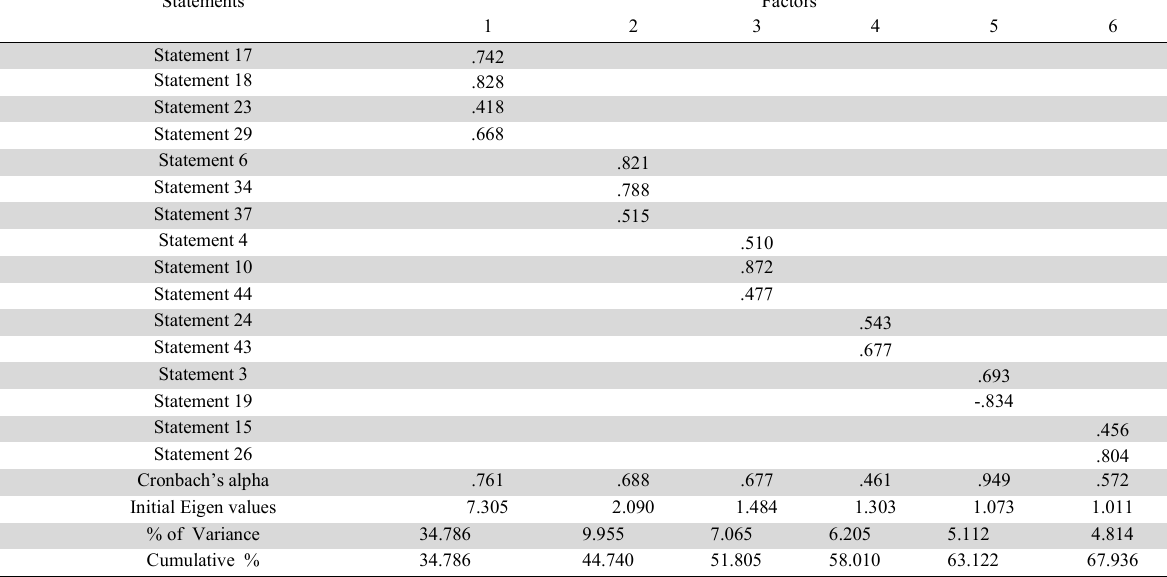
Exhibiting the factor loading in terms of Rotated Component Matrix Statements Factors 1